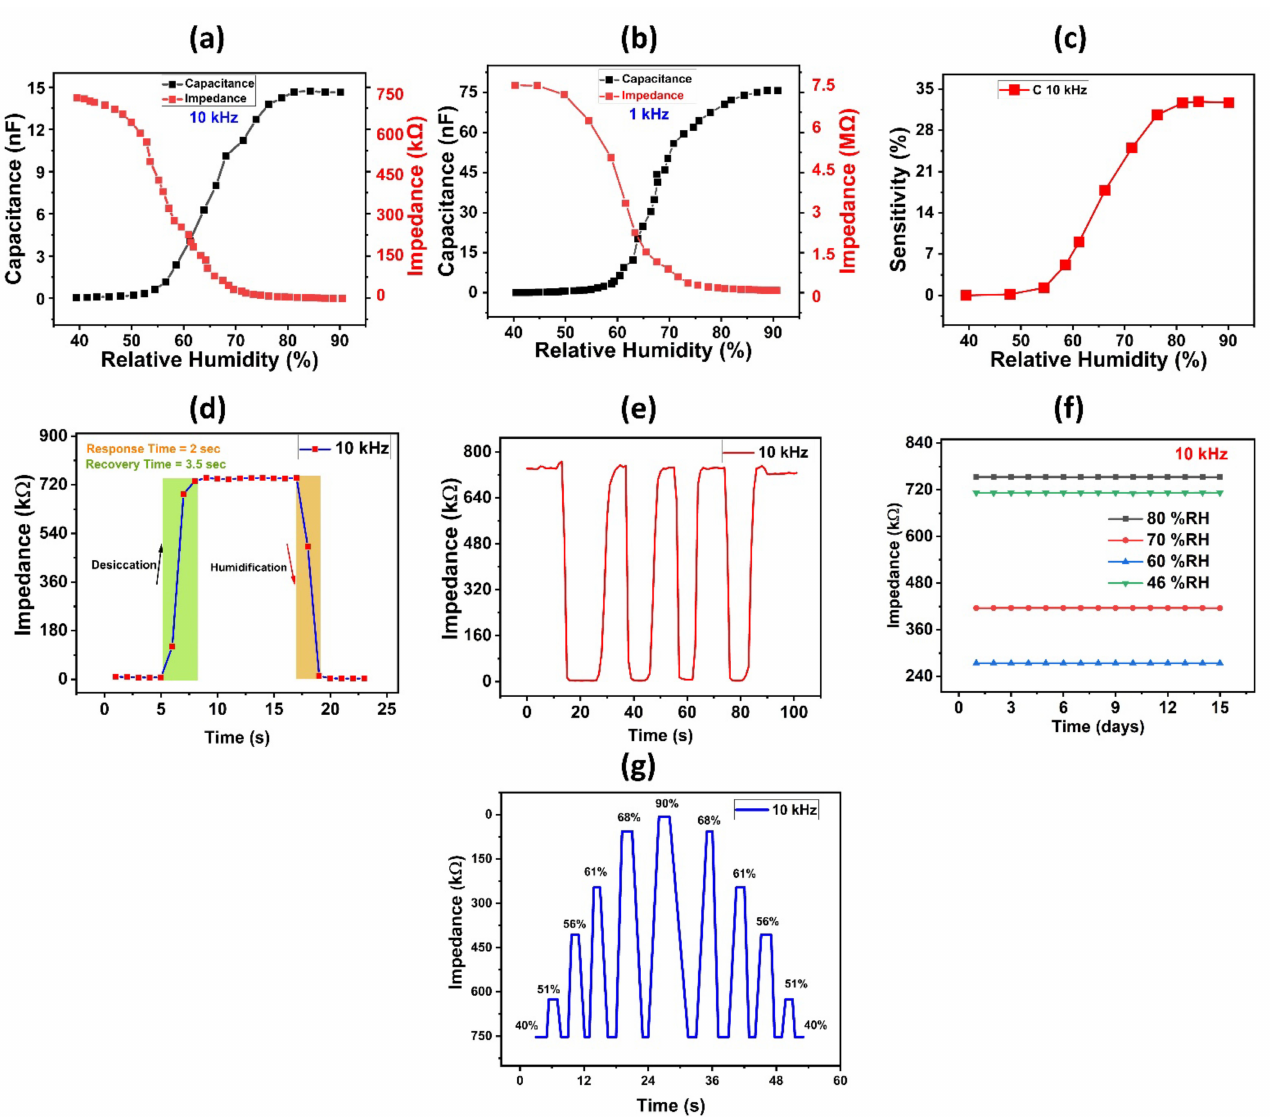
Figure 4. ( a ) Capacitance and impedance response of the proposed sensor at 10 kHz. ( b ) Capacitance and impedance response of the proposed sensor at 1 kHz. ( c ) Sensitivity response of proposed humid- ity sensor. ( d ) Response and recovery time graph. ( e ) Reproducibility of humidity sensor over various cycles of humidification and desiccation. ( f ) Stability results of humidity sensor. ( g ) Impedance responses of PVA/GF composite under switching